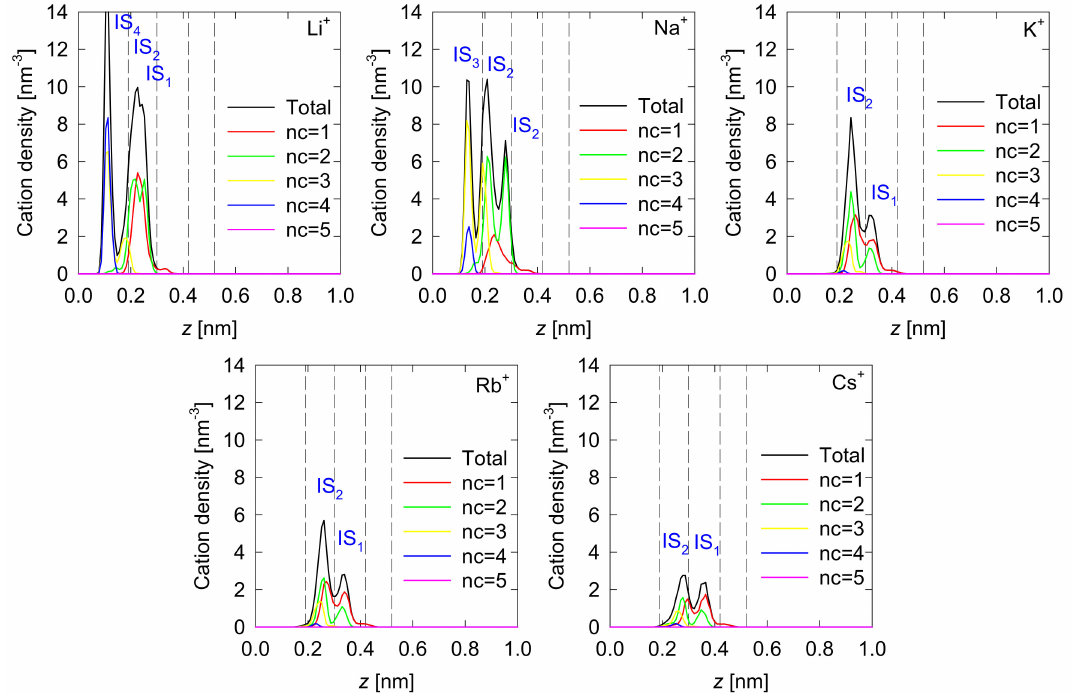
Figure 3. Axial density profiles of alkali metals close to negatively charged (110) spodumene surface. Surface charge density is − 0.125 C/m 2 . The mean position of peaks from the water density profile is represented by the segmented vertical lines. IS 1 , IS 2 , IS 3 , and IS 4 are inner-sphere complexes, respectively, with nc (number of contacts) equal one, two, three, and four contacts between the cation and the spodumene surface. The envelope of the density profile is called Total.